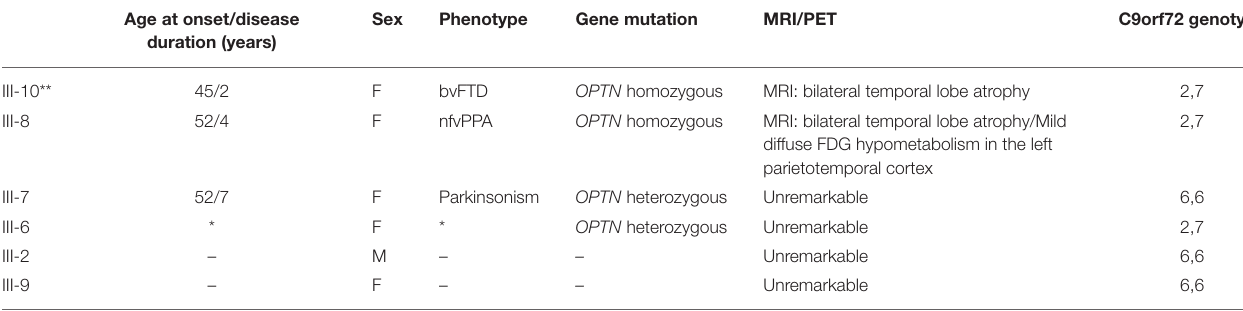
TABLE 1 | Summary of demographic, clinical and genetic profile of family members. Age at onset/disease duration